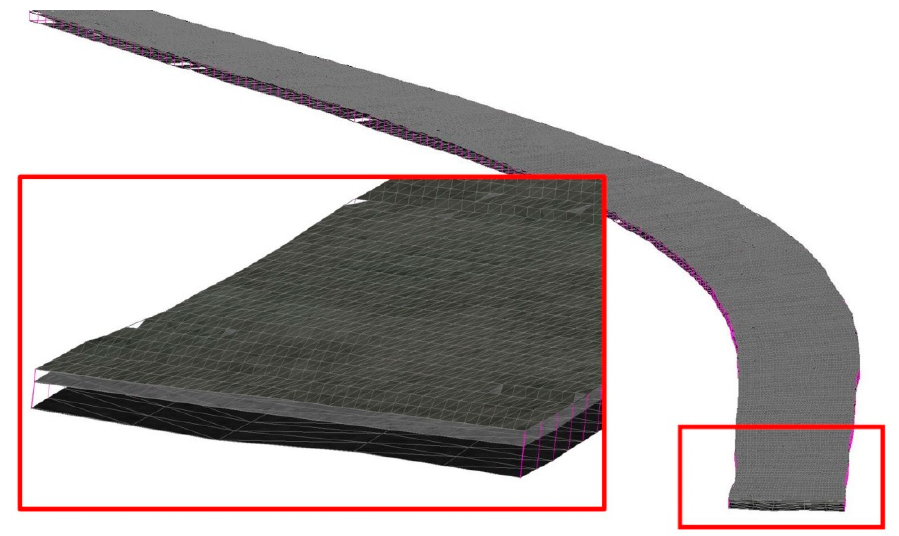
Figure 11. The pavement digital